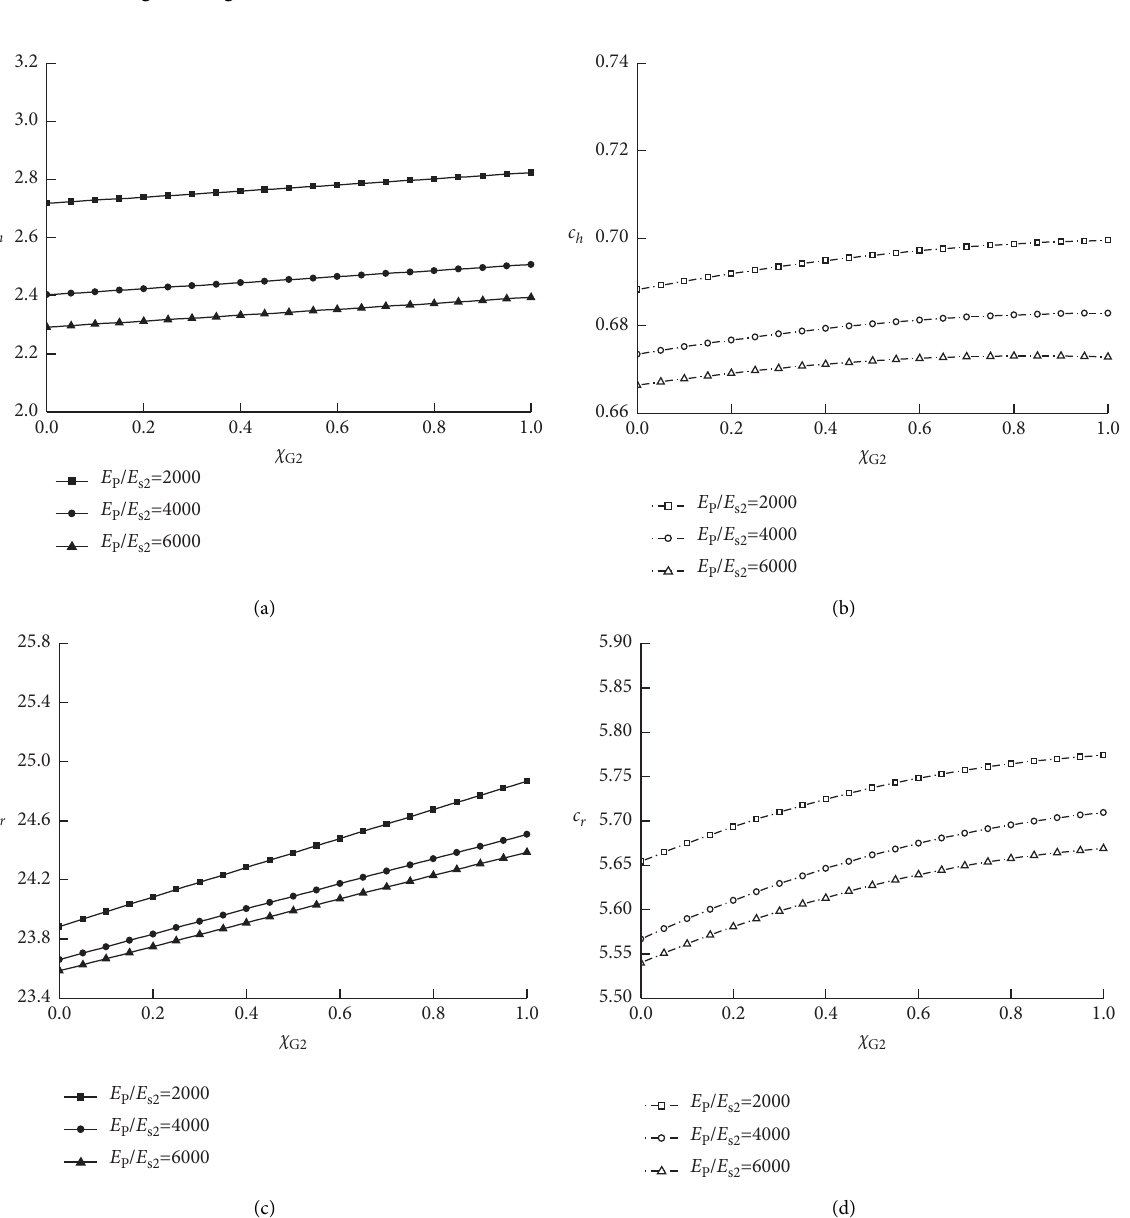
Figure 8: Effects of the soil shearing effect and pile-soil elastic modulus ratio change on the pile top complex impedance. (a) Horizontal dimensionless dynamic stiffness. (b) Horizontal dimensionless dynamic damping. (c) Sway dimensionless dynamic stiffness. (d) Sway dimensionless dynamic